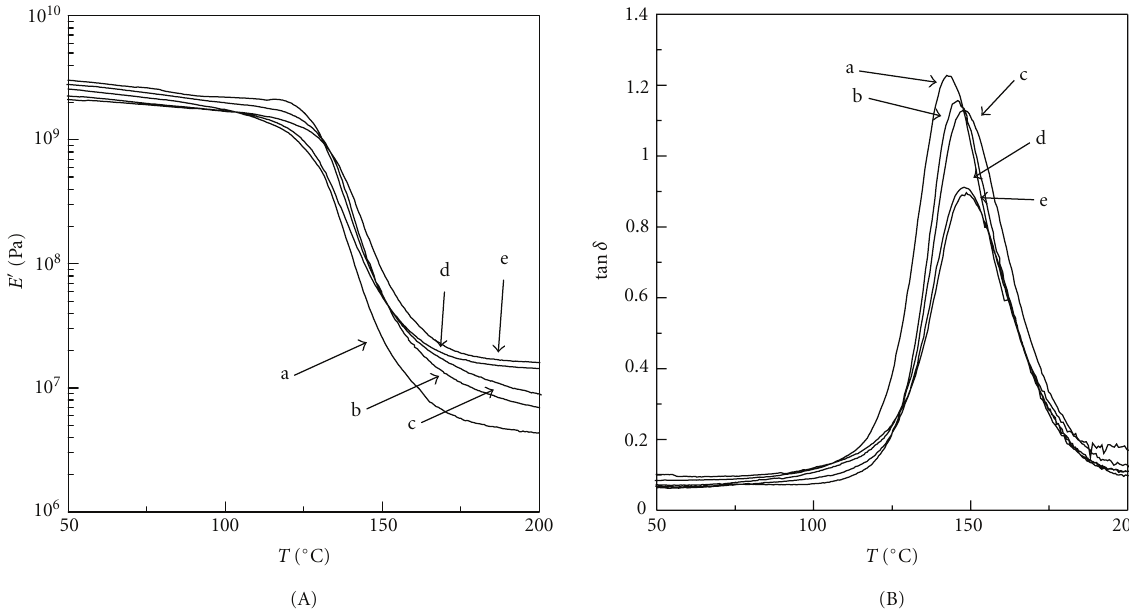
Figure 10: Trend of the storage modulus E (cid:3) (A) and loss tangent tan δ (B) for BPMn samples and pure PMMA sample as a function of temperature: PMMA (a), BPM4 (b), BPM6 (c), BPM9 (d), and BPM10 (e).